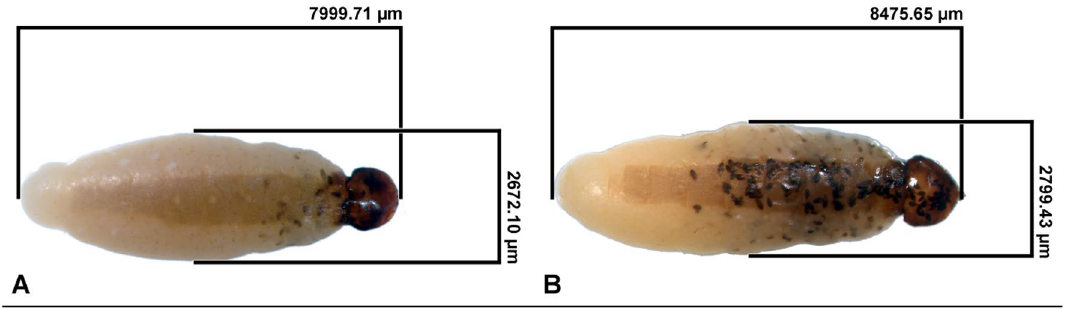
Figure 5. Two X. vesparum overwintering females containing few ( a ) and many ( b ) developed triungulins inside the brood canal. The amount of fully developed triungulins visible within the brood canal was variable, probably due to the presence of different developmental stages at the time of